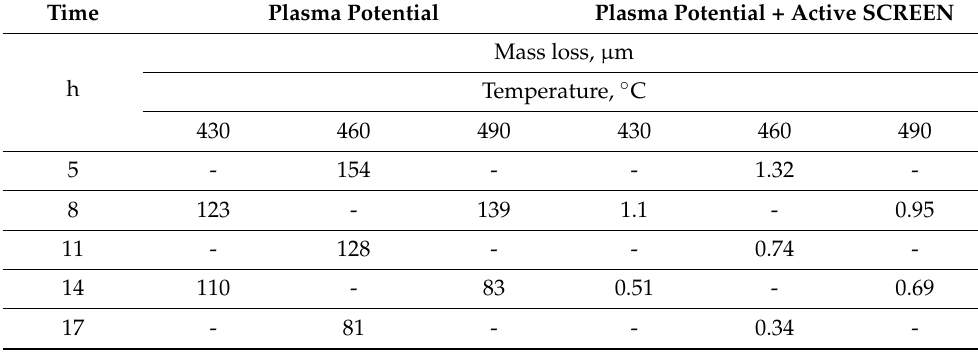
Table 6. Mass loss of the nitrided layer on the 316-steel substrate for different areas of the glow discharge.